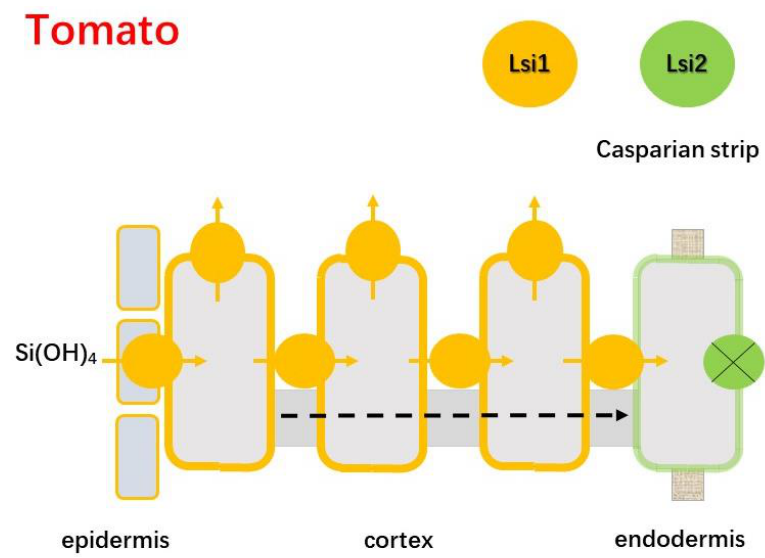
Figure 4. Schematic model of the Si transport system in tomato.